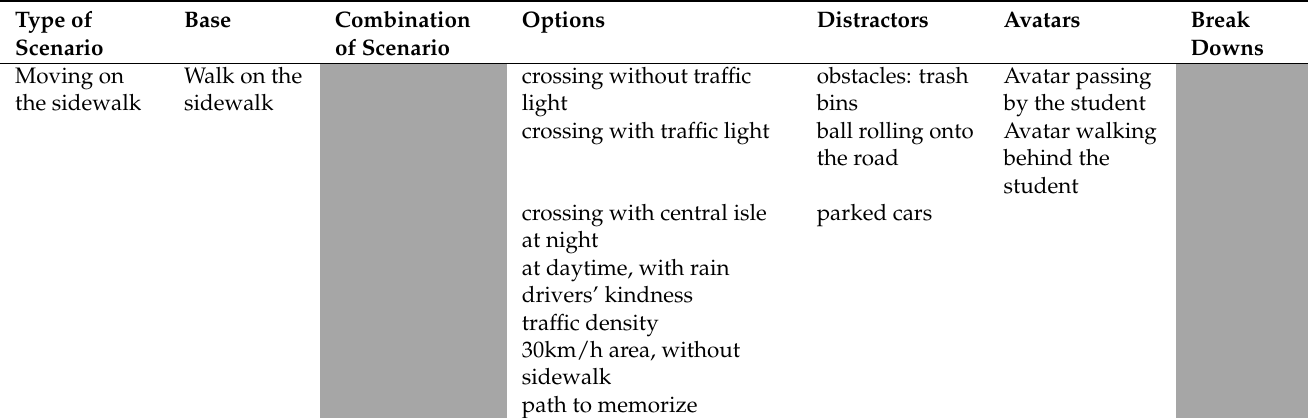
Table A1. Crosswalk and moving in the street scenario variations.